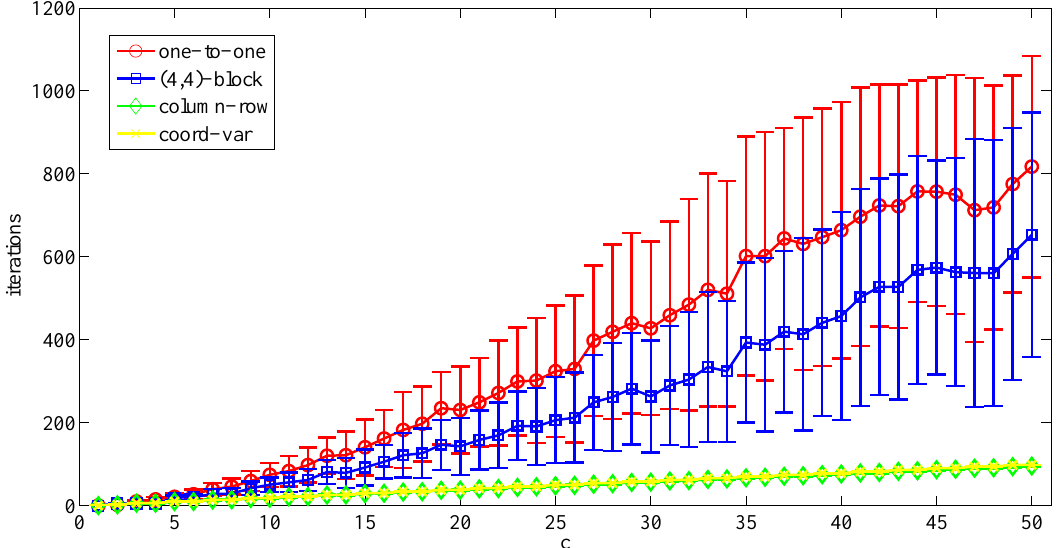
Figure 11. Average number of meetings ( ± its standard deviation) required to converge to the specified area partition strategy depending on the number of UAVs and considering a 1 × c configuration and different coordination